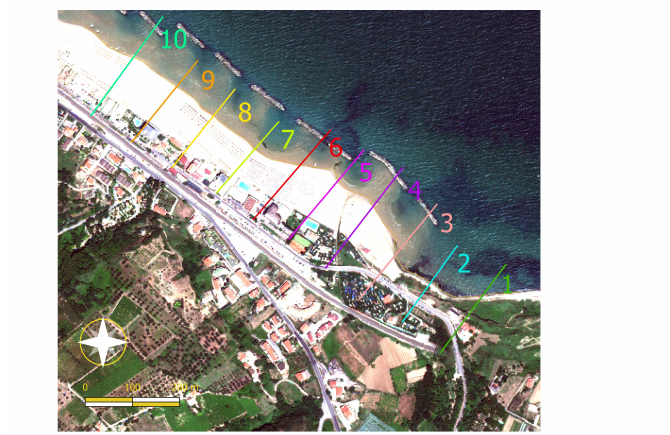
Figure 8. Ten transects every 100 m, drawn from the land to the sea, to calculate the intersection between them and seven shorelines extracted from WorldView-2, WVWI, J-Net Dynamic on the VHR image, Sentinel-1, Sentinel-2, Canny and J-Net Dynamic on the HR